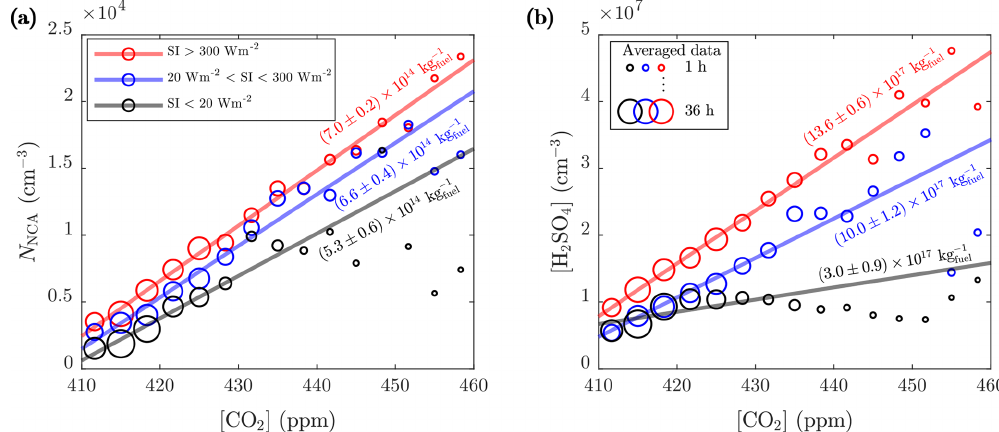
Figure 7. The 1min averages of the (a) NCA and (b) H 2 SO 4 concentrations further averaged to CO 2 concentration bins for three SI ranges (see Fig. 6 for the details on averaging and linear regression). The slopes of the linear fits converted to kilograms of fuel combusted (using the emission factor of CO 2 , 3.14kg per 1kg of fuel combusted; Yli-Tuomi et al., 2005) are marked in the figure. The intercepts of the fits at 410ppm are (a) ( 0 . 07 ± 0 . 04 ) × 10 4 , ( 0 . 15 ± 0 . 05 ) × 10 4 , and ( 0 . 25 ± 0 . 03 ) × 10 4 cm − 3 and (b) ( 0 . 67 ± 0 . 07 ) × 10 7 , ( 0 . 49 ± 0 . 15 ) × 10 7 , and ( 0 . 79 ± 0 . 06 ) × 10 7 cm − 3 for the lowest, the middle, and the highest SI ranges, respectively.